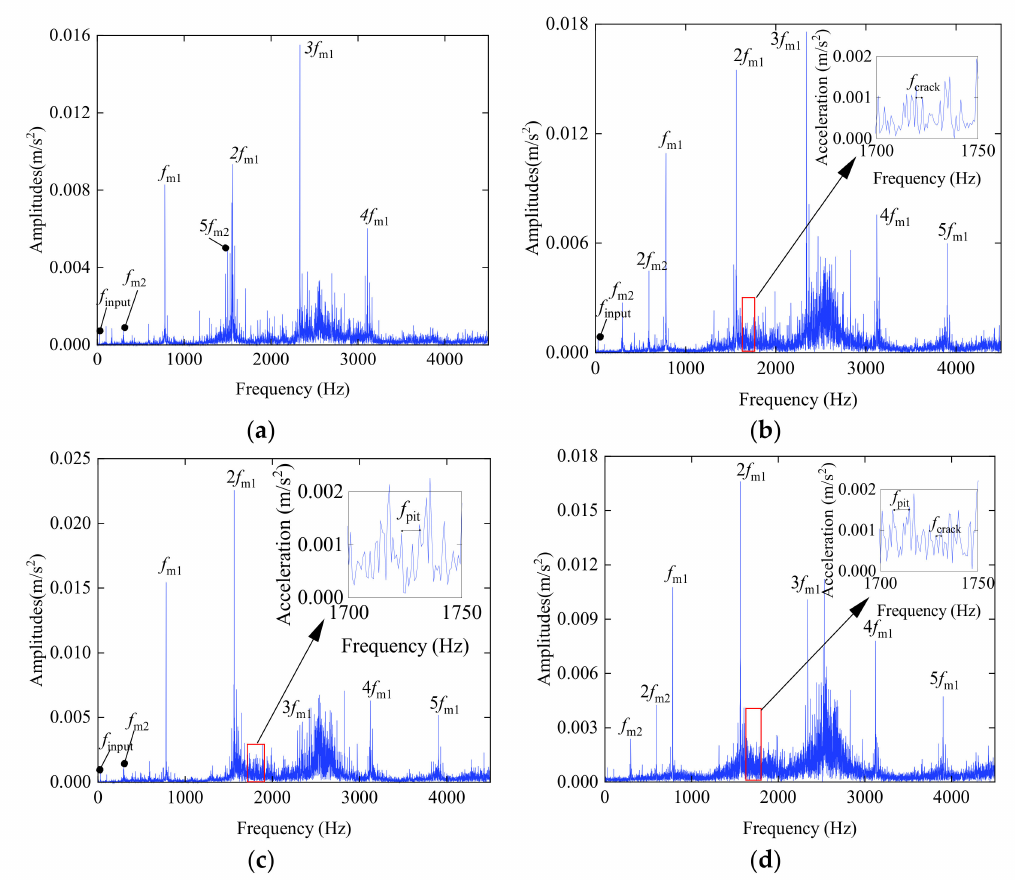
Figure 26. Experimental acceleration signals in frequency domain of gear transmission systems with different types of faults: ( a ) Normal gear system; ( b ) Gear system with cracks; ( c ) Gear system with pitting; ( d ) Gear system with cracks and